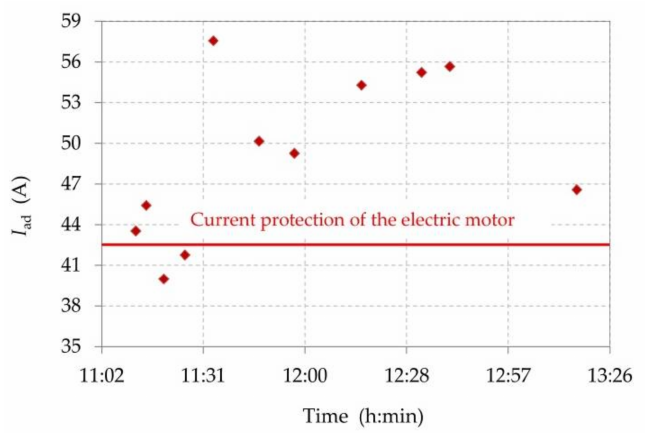
Figure 20. Theoretical values of the current in the state “without” cooling the compressor